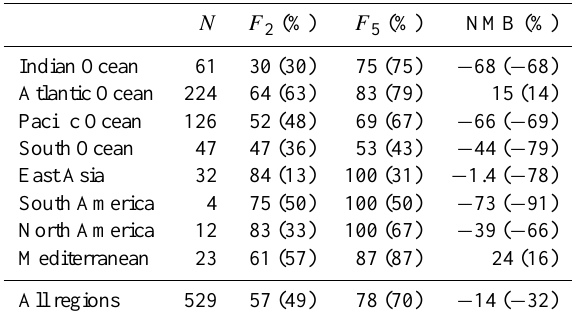
Table 3. Statistics for the comparison of modelled and observed Fe concentrations. N , sample size; F 2 and F 5 , fractions of stations with deviations within a factor of 2 or 5, respectively; NMB, normalized mean bias. The values in parentheses show the indicators when the combustion sources are not included.